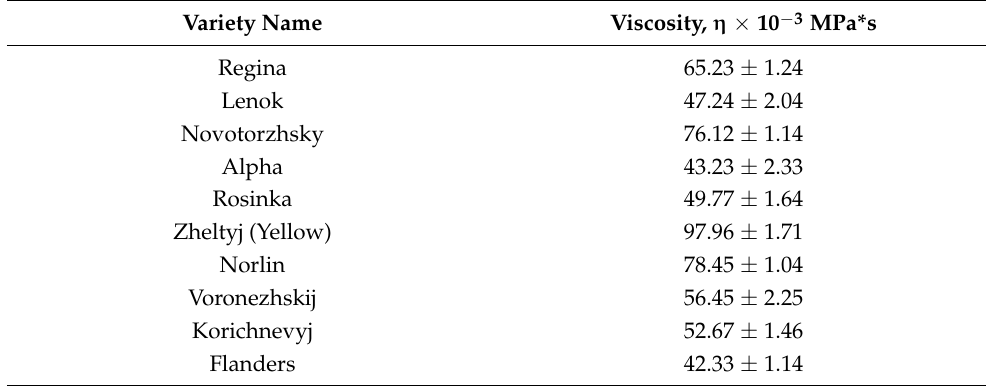
Table 8. Viscosity levels of the studied flax mucilage